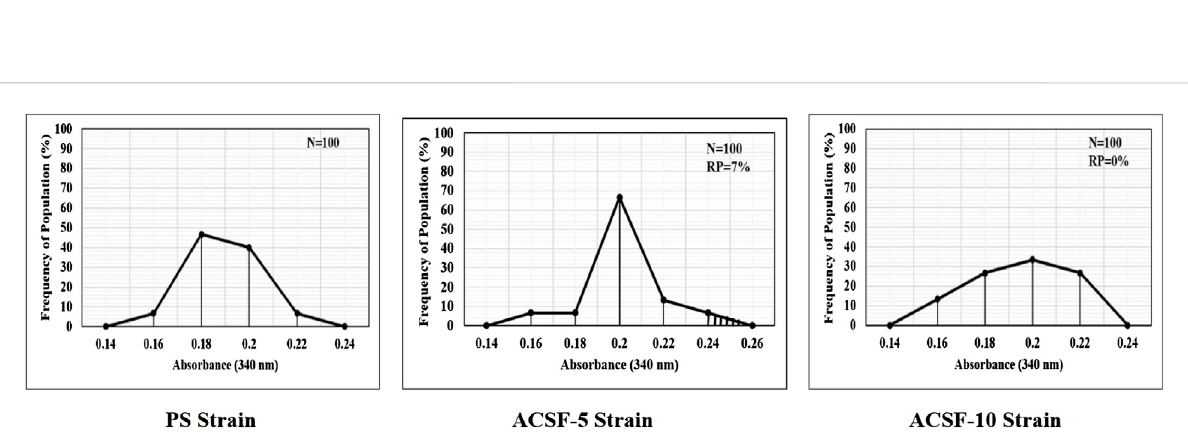
FIGURE 5 Frequency distribution of absorbance value (340 nm) as the GST activity in the larvae of PS (parent susceptible strain), ACSF-5 (acetamiprid larval-selected fi lial-5), and ACSF-10 (acetamiprid larval-selected fi lial-10) strains of Aedes aegypti ( n = 100). The susceptibility threshold is based on the maximum absorbance in the PS strain. The shaded region represents the resistant population (beyond the threshold). n = number of larvae; RP = resistant